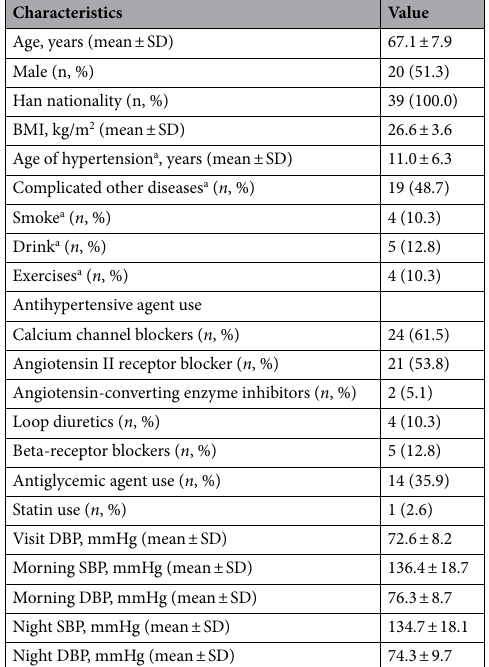
Table 1. Sociodemographic and clinical characteristics. a Age of hypertension: the time since the patient was diagnosed with hypertension by the hospital. Complicated other diseases: complicated other diseases include stroke, coronary heart disease and diabetes mellitus. Smoke: continuing to smoke for more than one year. Drink: drinking more than once a week on average. Exercises: exercise more than three times a week, and not less than 30 min each time.